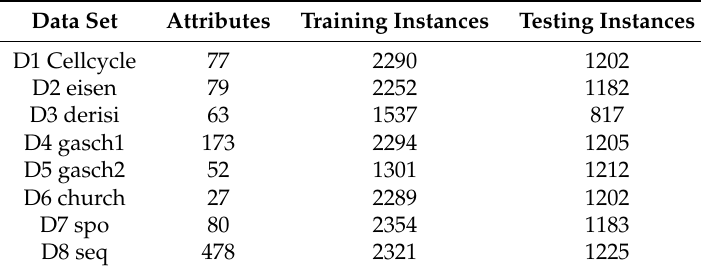
Table 1. The characteristics of the experimental